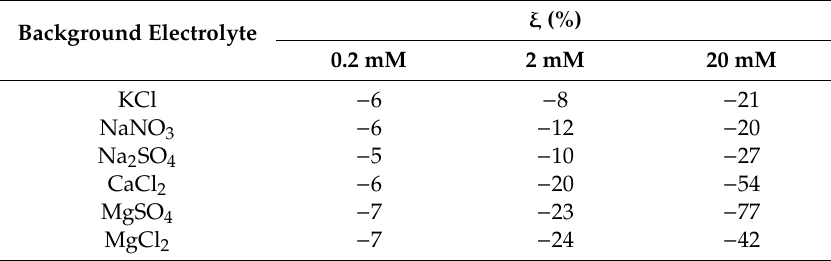
Table 3. E ff ect of background electrolytes at concentrations of 0.2, 2, and 20 mM on the global performance index of the biosorption of Ni 2 + by